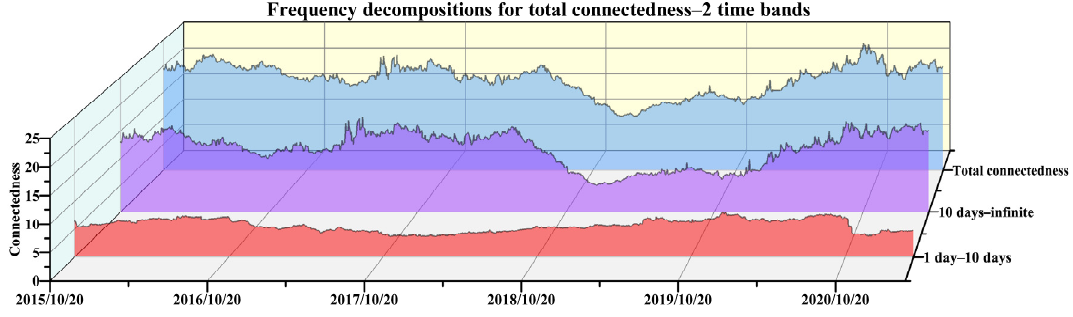
Figure 6. Total demand connectedness and frequency decomposition with two time bands.